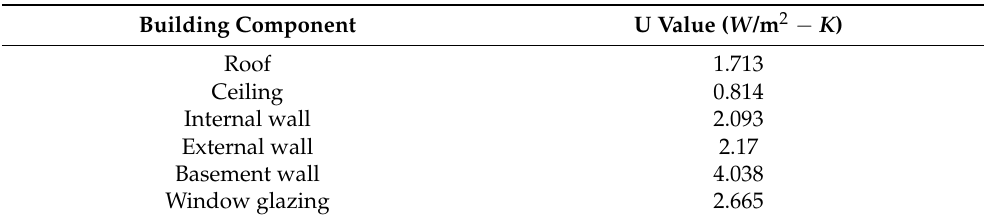
Table 1. Key design data of the building envelope.